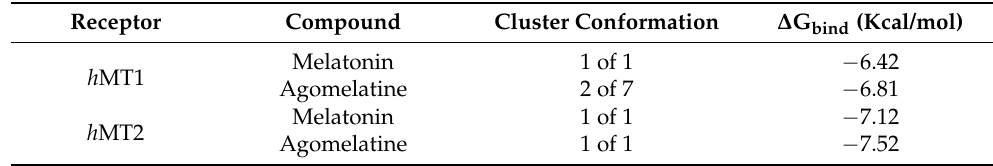
Table 1. Free Gibbs binding energies ( ∆ G bind ) associated with the docked poses are reported in Figure